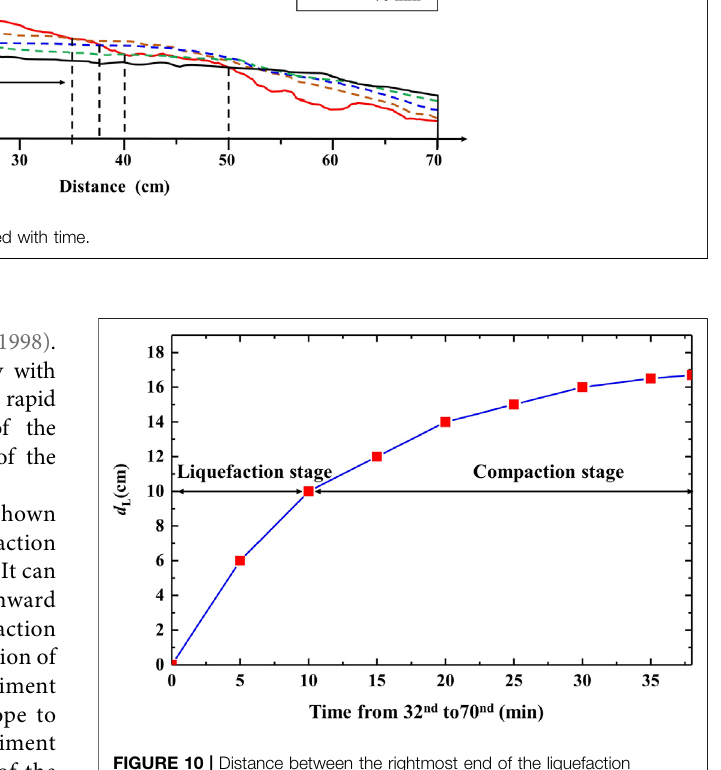
Frontiers in Earth Science |